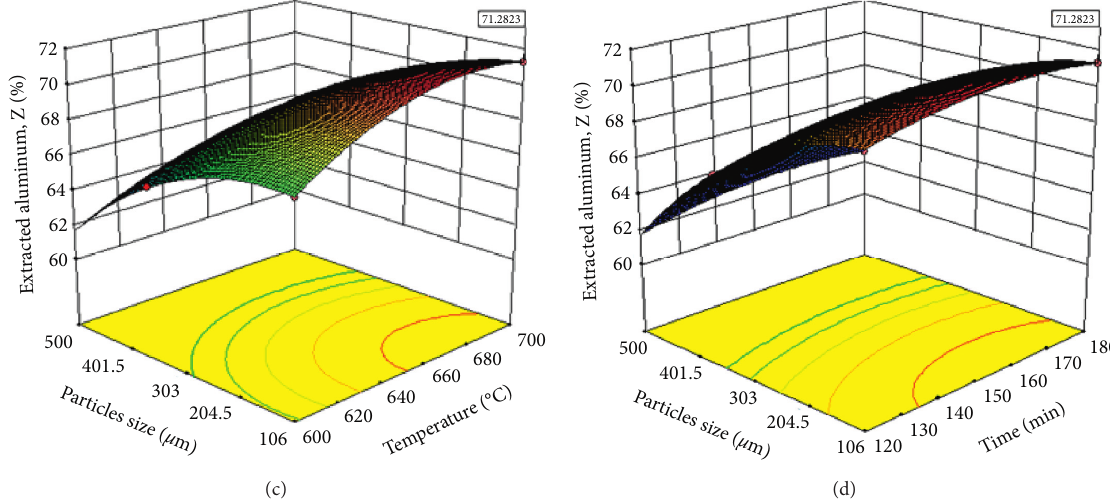
Figure 6: Model graphs of (a) perturbation plot of calcination temperature, time, and particles size on extracted aluminum, (b) the surface plot of calcination temperature and time effect, (c) the surface plot of calcination time and particles size effect, and (d) the surface plot of calcination temperature and particles size effect on extracted aluminum. Table 8: Comparison of the present study with various literature. Origin of